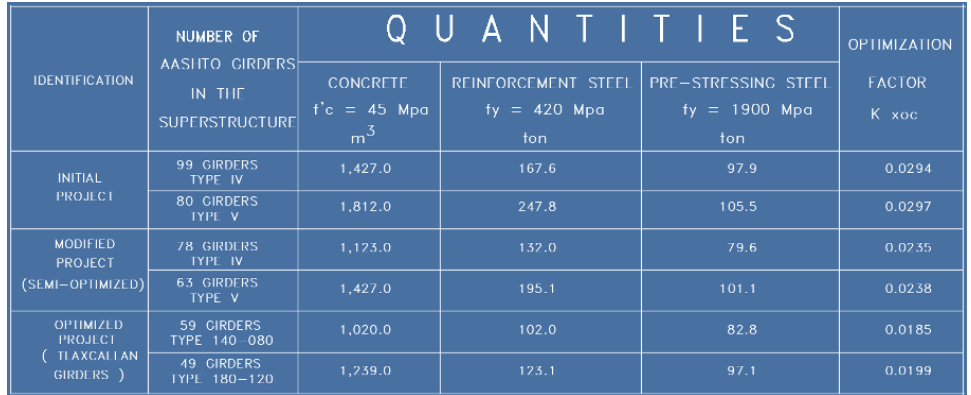
Figure 6. Study case to show the K xoc factor and the relation between the number of girders and the consumption of